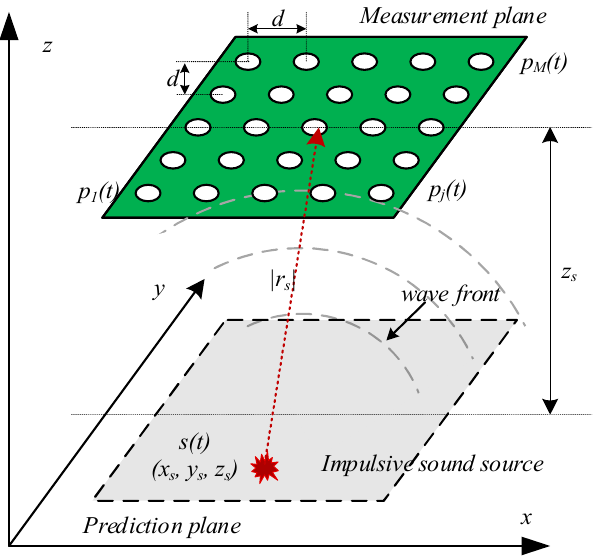
Figure 4. Sound measurement setup and spherical acoustic waves emitted by a monopole source.